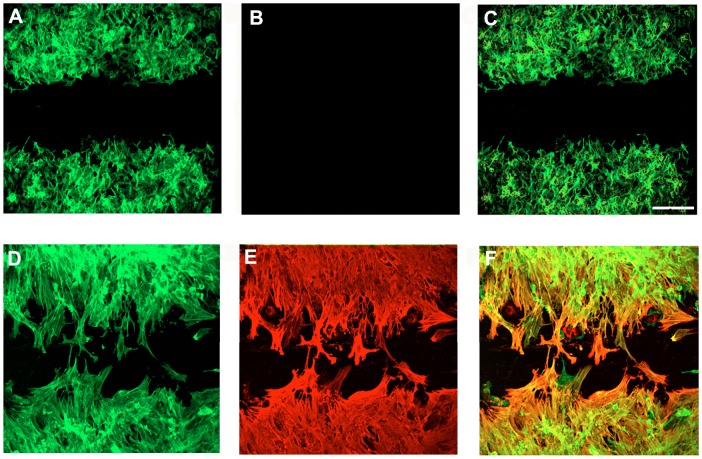

Acta2 expression in normal and injured stellate cells during cell migration.Stellate cells from normal and injured liver (carbon tetrachloride) were isolated, plated at equivalent density and allowed to adhere in culture overnight as in Figure 1. After 12 hours, a linear scratch was applied to the monolayer. Twenty-four hours later, cells were fixed and dual labeled with anti-cytoplasmic β-actin and anti-Acta2 antibodies as in Methods. In (A, cytoplasmic β-actin) and (B, Acta2), representative examples of cells from normal livers after scratch wounding are shown. In (D, cytoplasmic β-actin) and (E, Acta2), cells from carbon tetrachloride treated animals are shown. In C and F, co-localization of β-actin and Acta2 is depicted in overlays. Representative areas from typical experiments (carbon tetrachloride) are shown (n = 15) (bar = 100 microns).